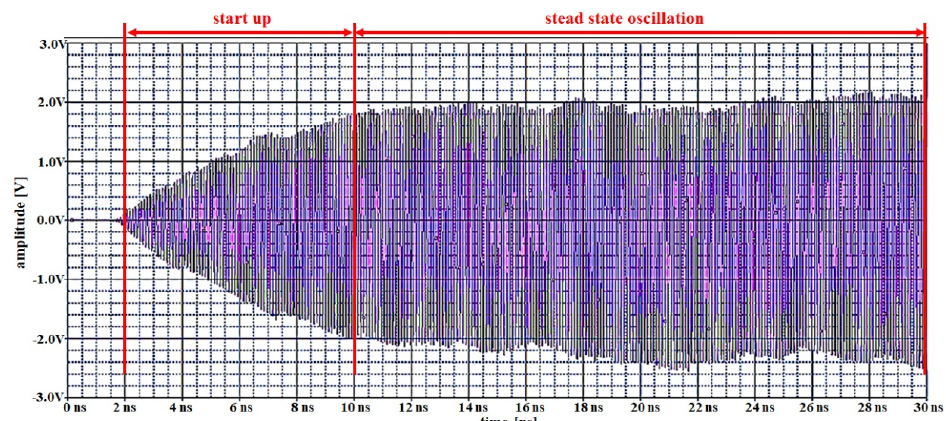
Figure 8. Result of simulating the oscillations of a Colpitts oscillator.